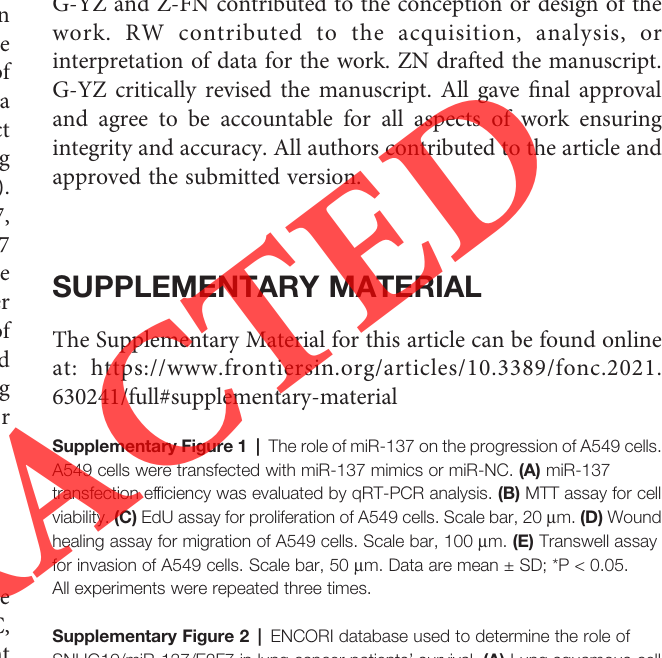
Supplementary Figure 3 | Inhibition of SNHG19 suppressed NSCLC growth in vivo. 30 mice were divided into two group randomly, A549 cells were subcutaneously injected into nude mice. And lentivirus packaged si-SNHG19 or si- NC was injected through tail vein. (A) Tumors was isolated after 4 weeks of